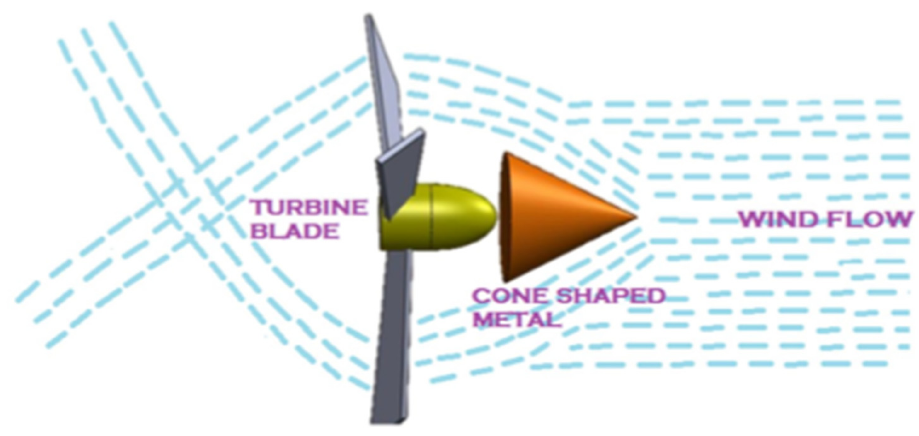
Figure 1. Proposed wind flow around the turbine blades due to the cone-shaped metal [24].